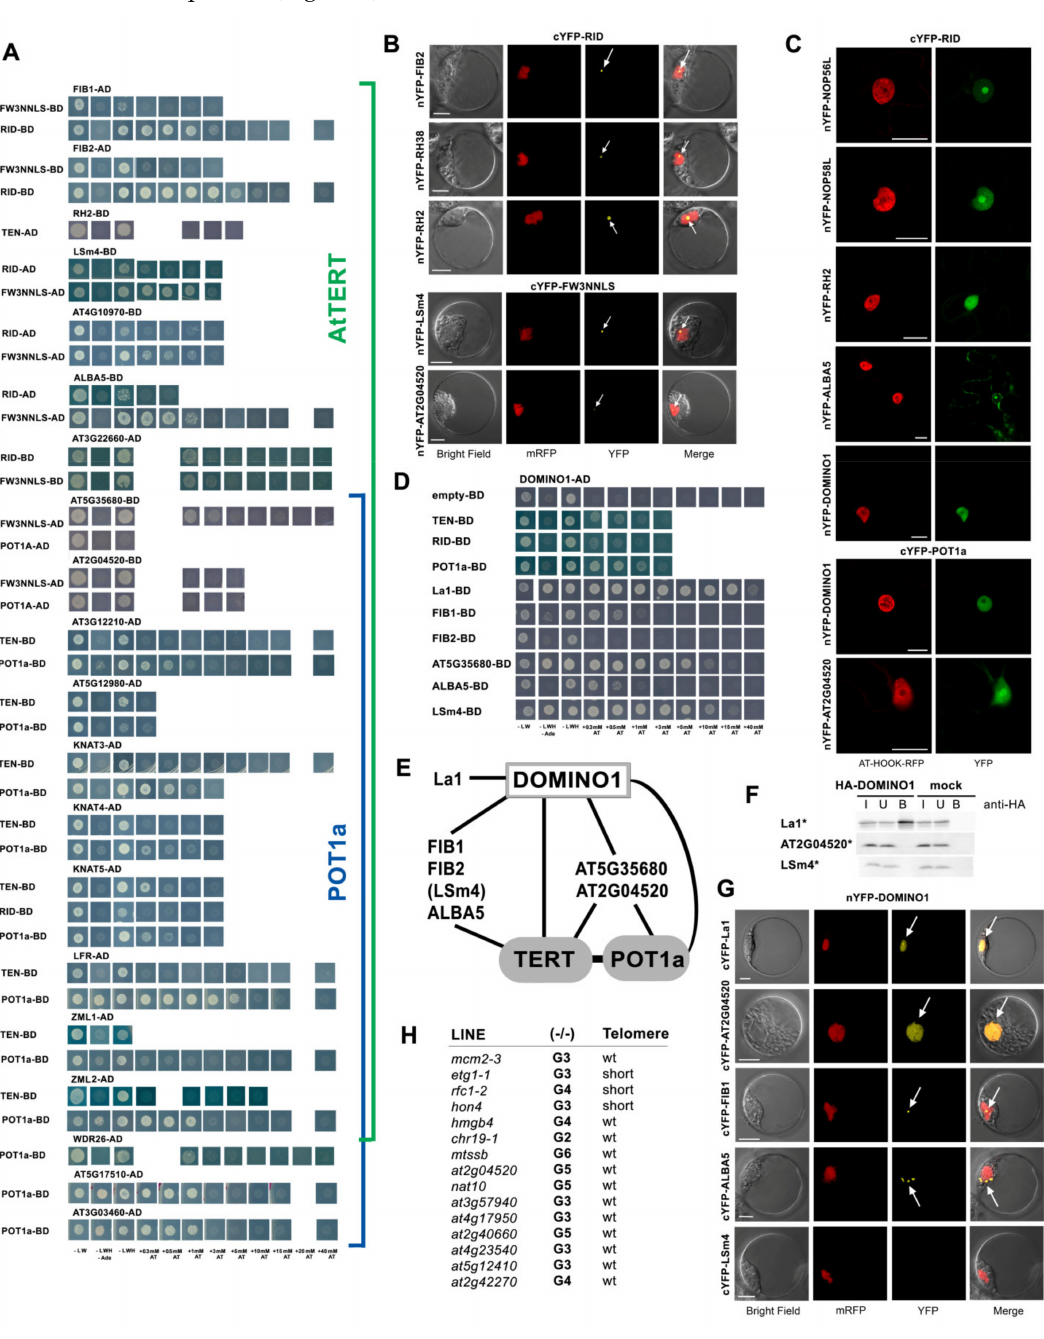
Figure 6. Interactions of candidate proteins involved in ribosome and RNA processing, transcription and gene regulation with AtTERT and POT1a constructs. ( A ) Positive Y2H interactions of twenty proteins with various constructs are documented in individual panels including interactions detected